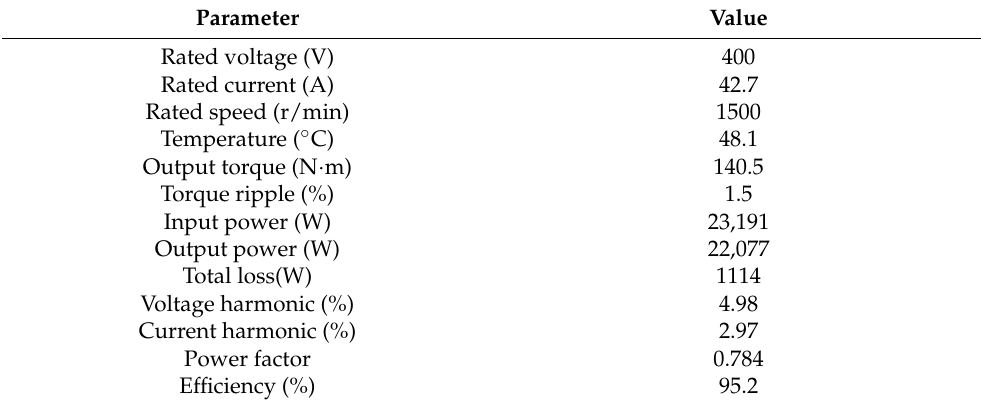
Table 10. Experimental Results.